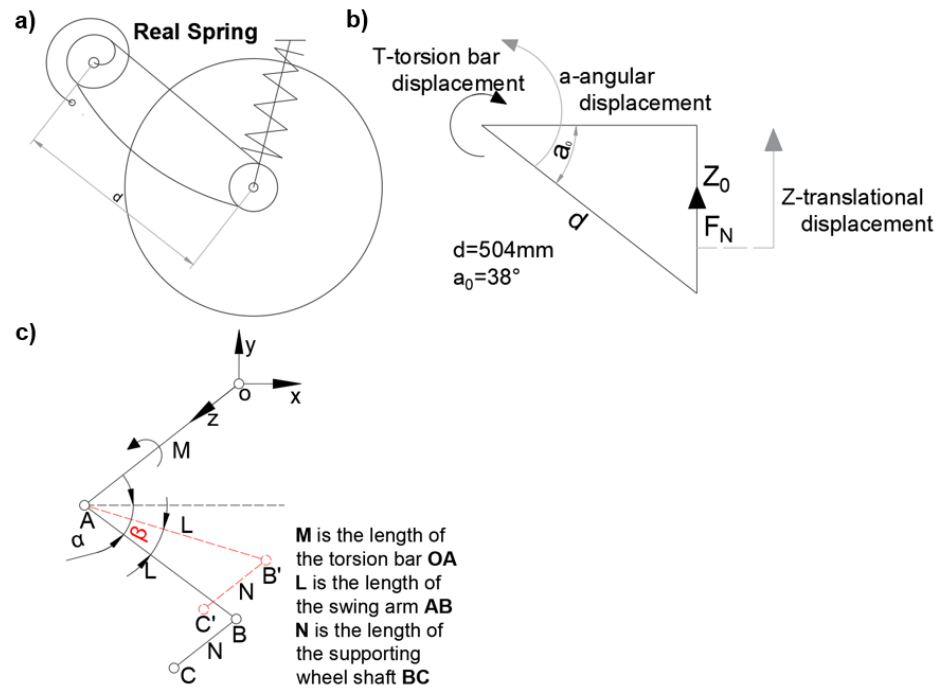
Figure 3. ( a ) Visual view of swing arm suspension. ( b ) Geometric representation (a0 is the angle between the swing arm and the horizontal direction). ( c ) Schematic diagram of swing arm torsion bar suspension subjected to impact load.